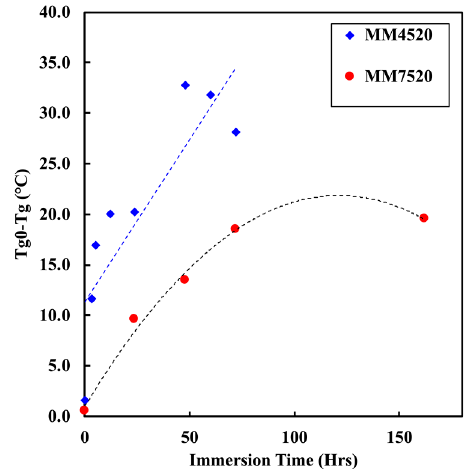
Figure 8. Graph showing a change in Tg with respect to immersion time in water for MM4520 and MM7520.